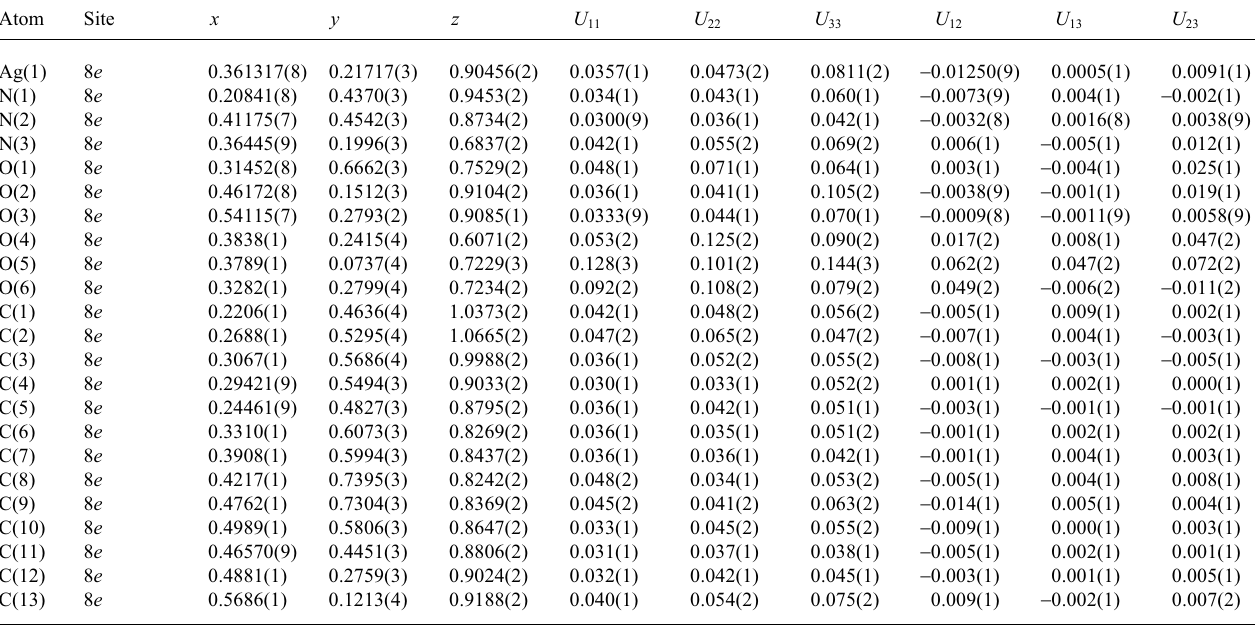
Table 3. Atomic coordinates and displacement parameters (in Å 2 )